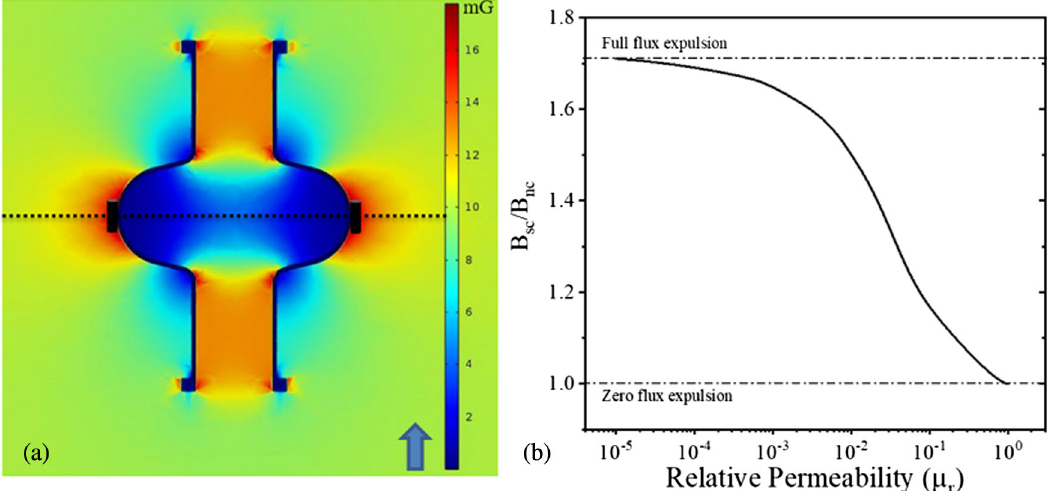
FIG. 3. (a) Contour plot of the magnetic field distribution around the perfectly diamagnetic cavity, B ¼ 10 mG, shown by the arrow. (b) The flux expulsion ratio as a function of relative permeability ( μ magnetic field B n the center of the FGM at the